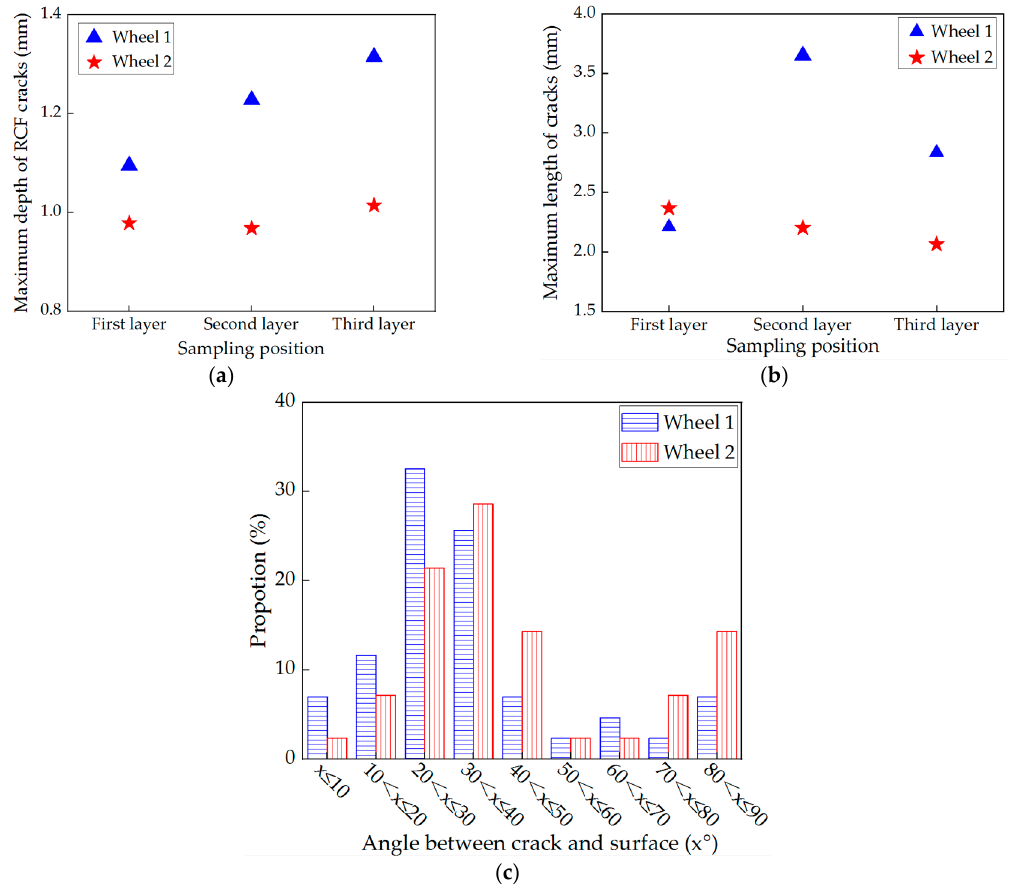
Figure 10. Statistics of RCF cracks on wheel 1 (standard wheel) and wheel 2 (improved wheel): ( a ) maximum depth and ( b ) maximum length of cracks; ( c ) distribution of crack angles.